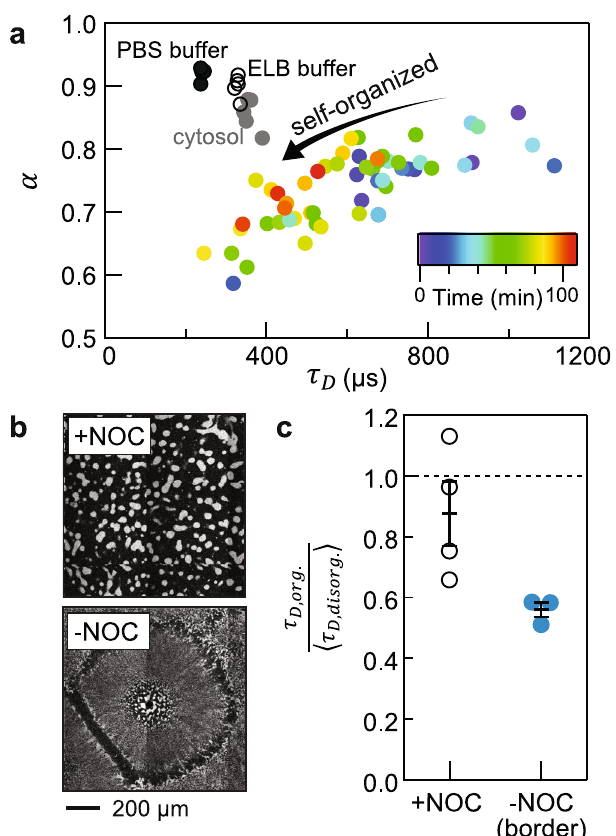
Fig. 3 | Cytoplasmic organization mediates protein diffusion. a FCS data from Fig. 2c – e consolidated in a parameter space of { α , τ D }. b Nocodazole (NOC, 33 µ M) abolishes self-organization of cytoplasm, visualized by ER-Red Tracker. c Nocodazole-treated cytoplasmic extracts show little changes in diffusion time (diffusion time ratio close to 1), compared with the sample without nocodazole at similartimepoints(<5min).The y -axisshows τ D normalized by theaverage τ D from early timepoints (<20min). Error bars, SEM. n =4 and three measurements of dif- ferent positions in an extract with and without nocodazole, respectively. Source data are provided as a Source Data fi